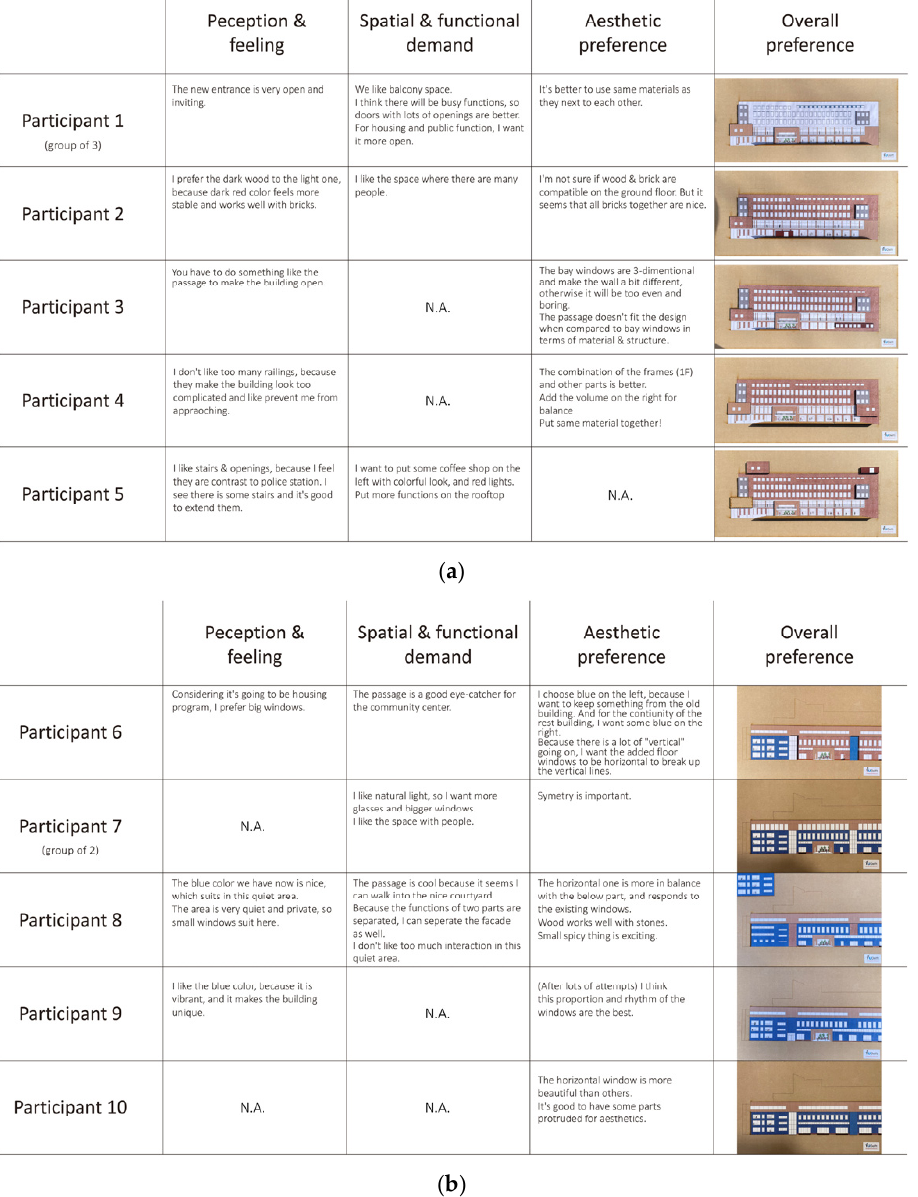
Figure 5. ( a ) West façade redesign testing results; ( b ) north façade redesign testing results.